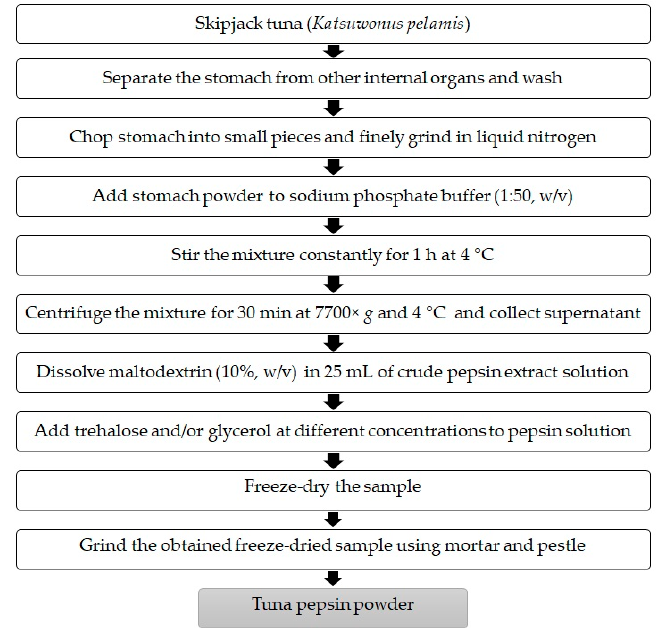
Figure 1. A flow chart of crude tuna pepsin powder production process. Relative Activity of TPP